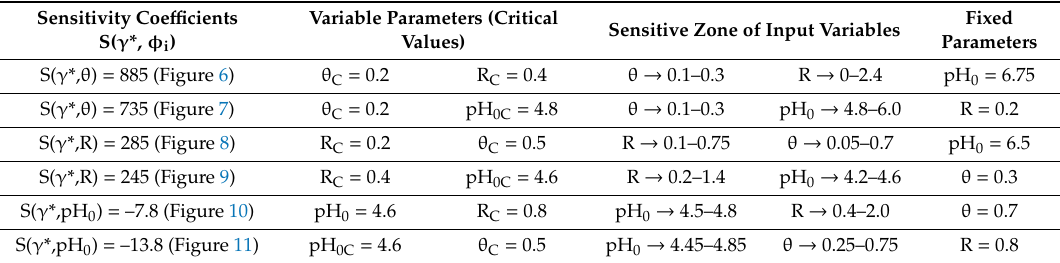
Figure 11. Normalized objective sensitivity S( γ *, pH 0 ) as a function of parameters pH 0 and θ . Table 6. Di ff erent critical values of input parameters (from Figures